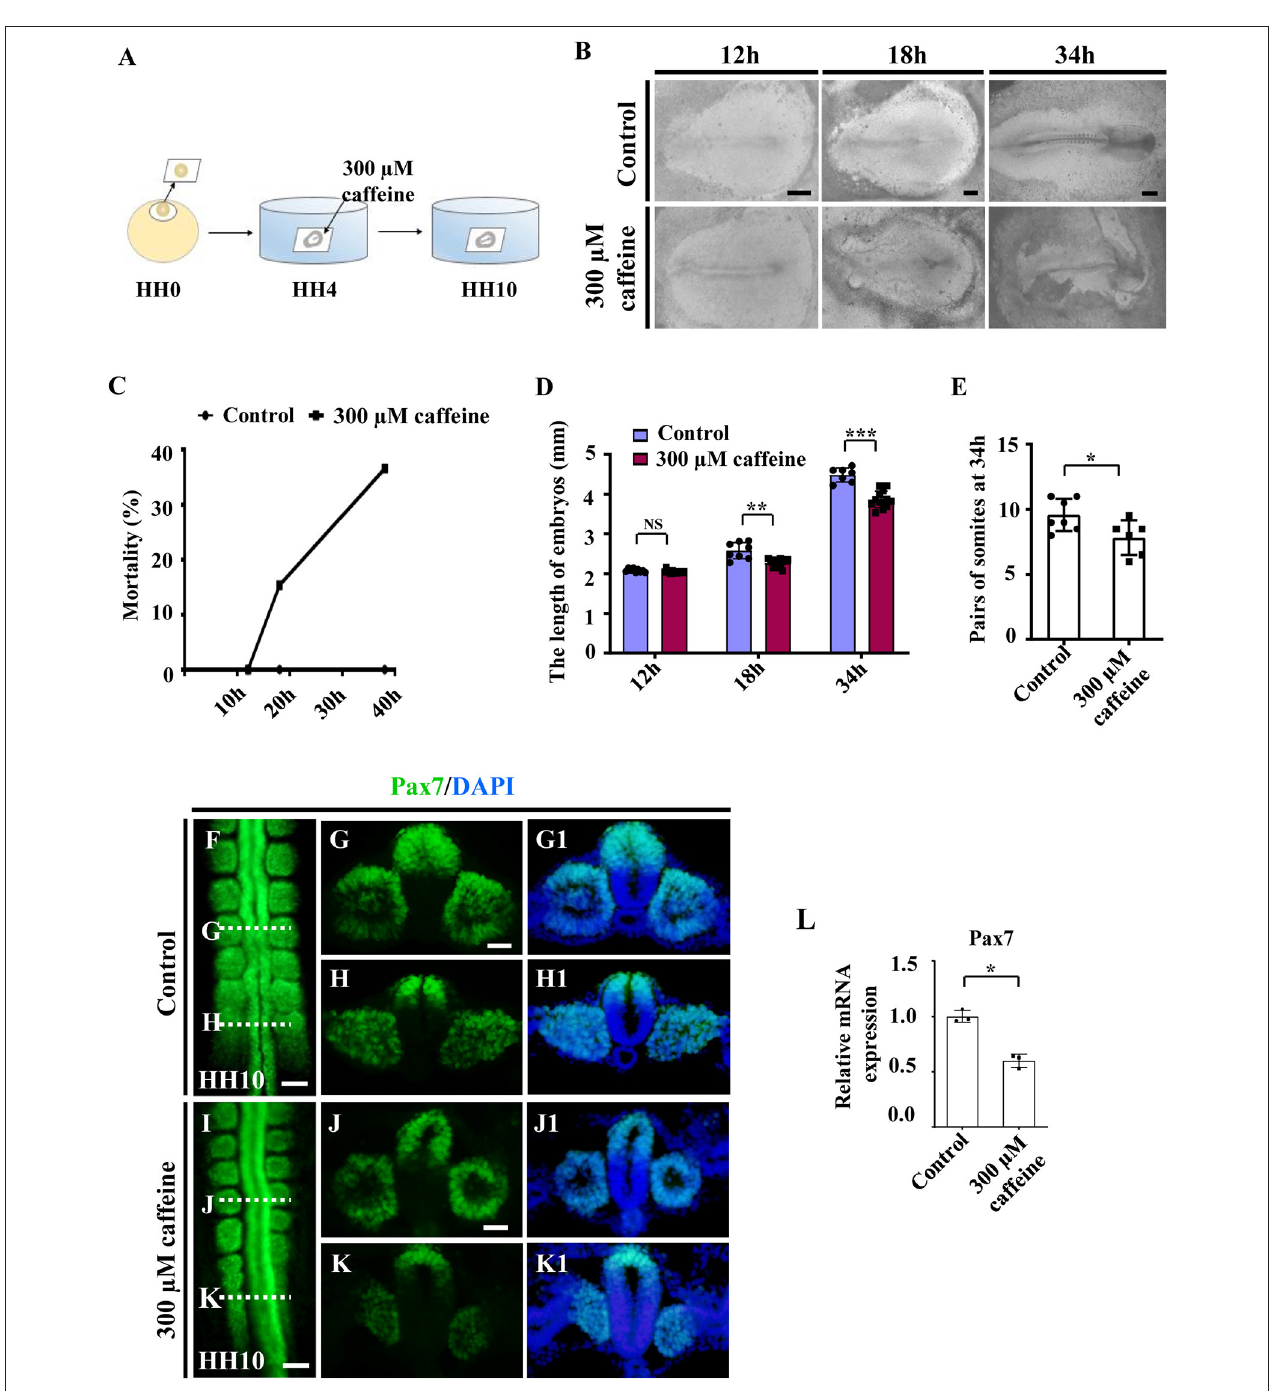
FIGURE 1 | Assessment of chicken somitogenesis following caffeine treatment. (A) The sketch illustrates the development of chicken embryos in early chick (EC) culture with or without caffeine. Caffeine was applied to the embryos at HH4 (12-h incubation). (B) Representative images of whole chicken embryos from the control and caffeine-treated groups, taken after 12, 18, and 34h of incubation. (C) The curve chart showing the comparisons of mortality of chicken embryos from the control and caffeine-treated groups. (D,E) The bar charts showing the comparisons of length and somite pairs of chicken embryos between the control and caffeine-treated groups. (F–K, G1–K1) Immunofluorescence staining of Pax7 in the chicken embryos from the control (F) and caffeine-treated (I) groups, and the corresponding transverse sections for Pax7 and merge with DAPI staining (G,H,J,K,G1,H1,J1,K1) . Panels (G/J) and (H/K) are from the seventh somites and presomitic mesoderm (PSM) of somites, respectively. (L) Quantitative RT-PCR data showing the mRNA expression of Pax7 from the control and caffeine-treated groups. Scale bars = 500 µ m in panel (B) ; 100 µ m in panels (F , I) ; 50 µ m in panels (G,H,J,K,G1,H1,J1,K1) . * P < 0.05, ** P < 0.01, *** P < 0.001.